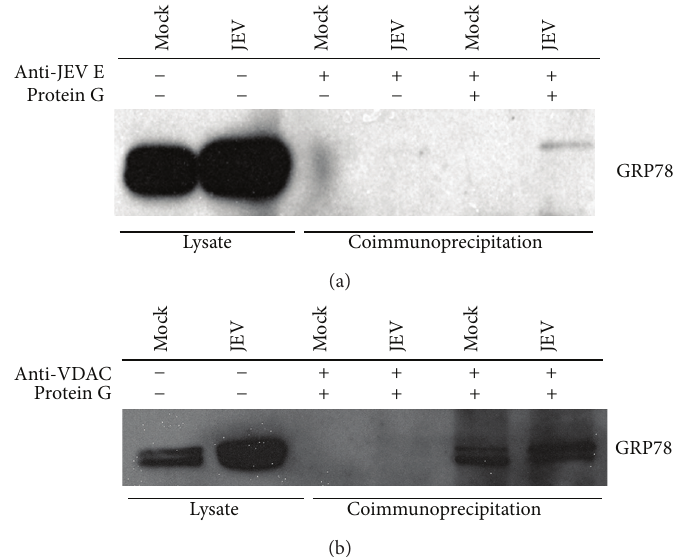
Figure 1: Coimmunoprecipitation analysis of GRP78 and JEV E protein and GRP78 and VDAC. C6/36 cells were mock and or infected with JEV for V days, after which cells were lysed and either E protein (a) or VDAC (b) immunoprecipitated with an appropriate antibody. Coimmunoprecipitation of GRP78 was determined by electrophoresis of the precipitated proteins and transfered to solid matrix support after which membrane was probed with an antibody against